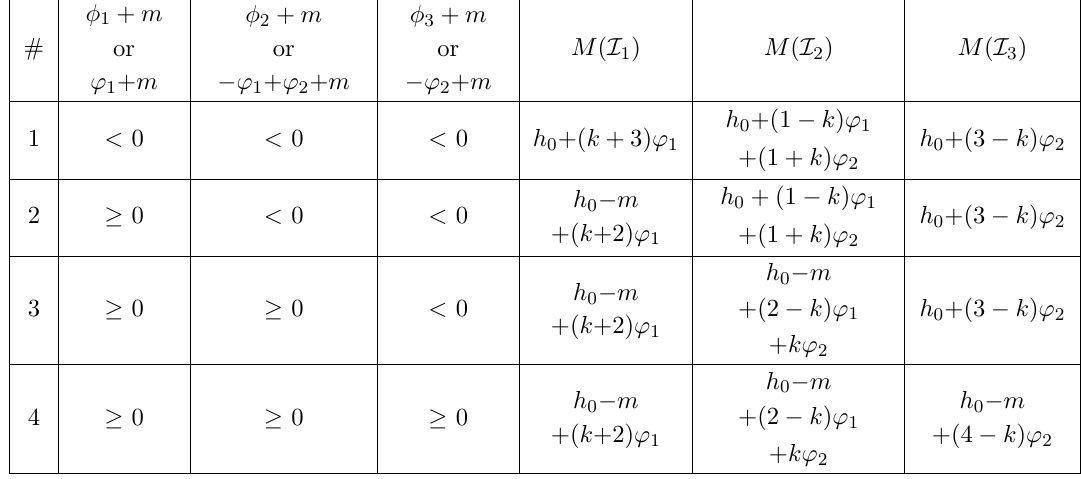
or SU(3) k gauge theory with N f = 1 and the eff eff